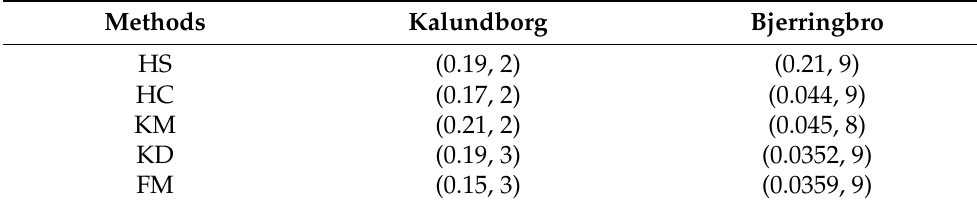
Table 6. C-index for each clustering method (statistic, number of clusters).